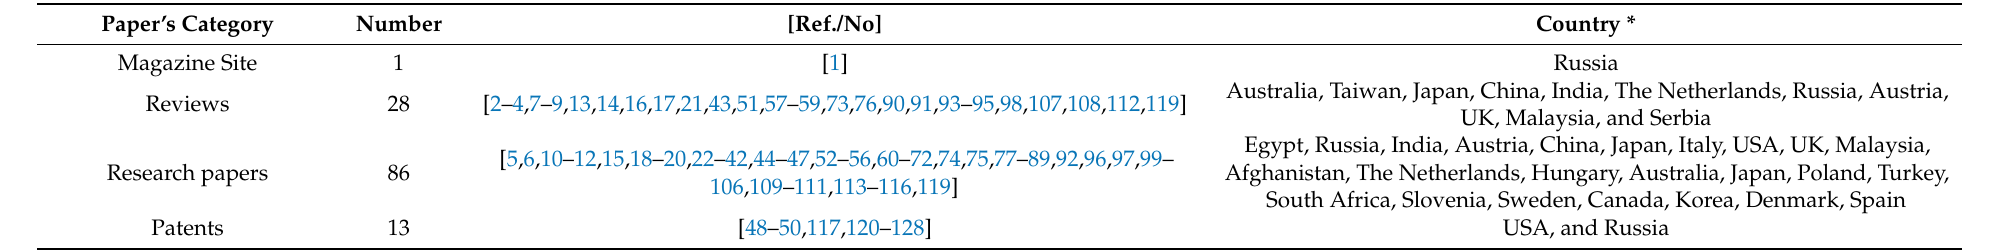
Table 2. Statistics of the sources